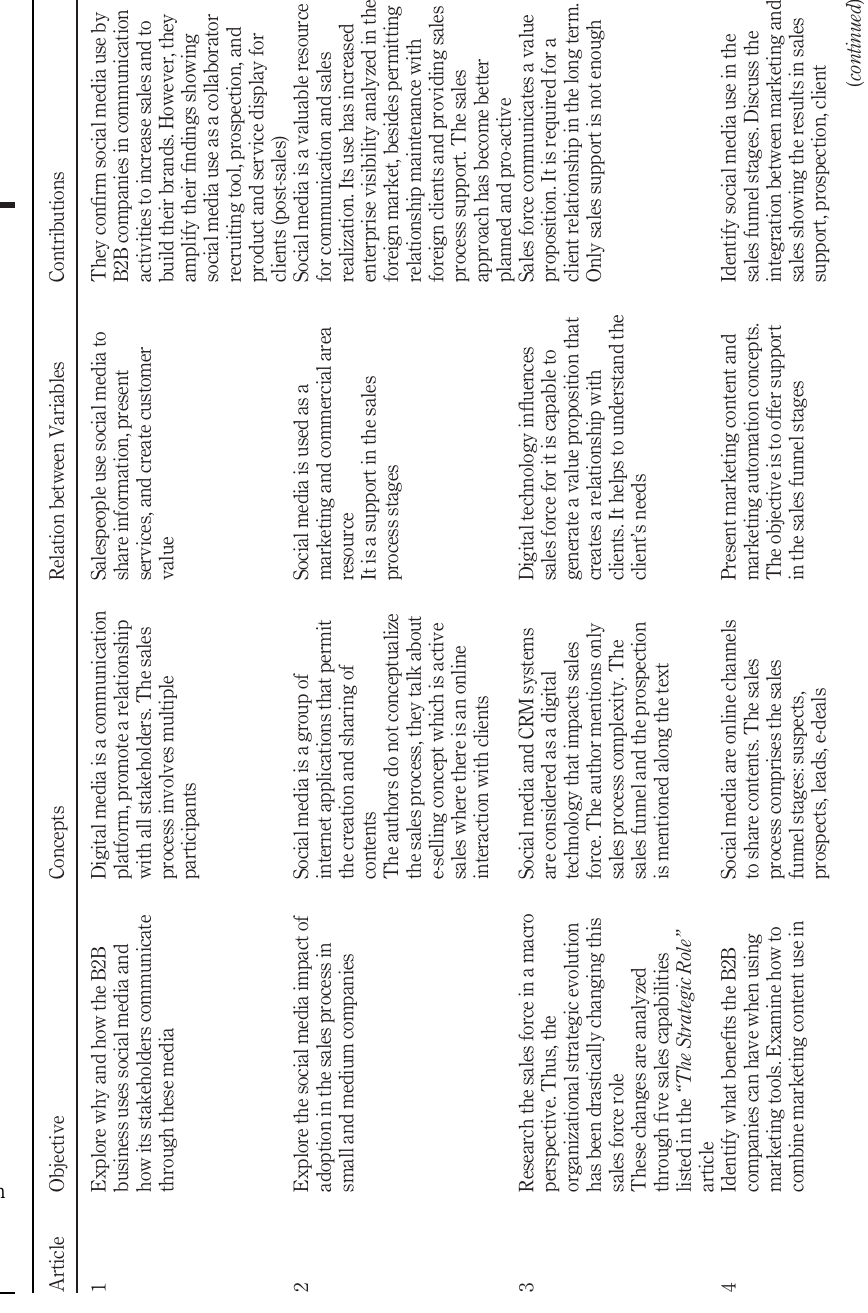
Table 5. Articles information for the Meta- Synthesis